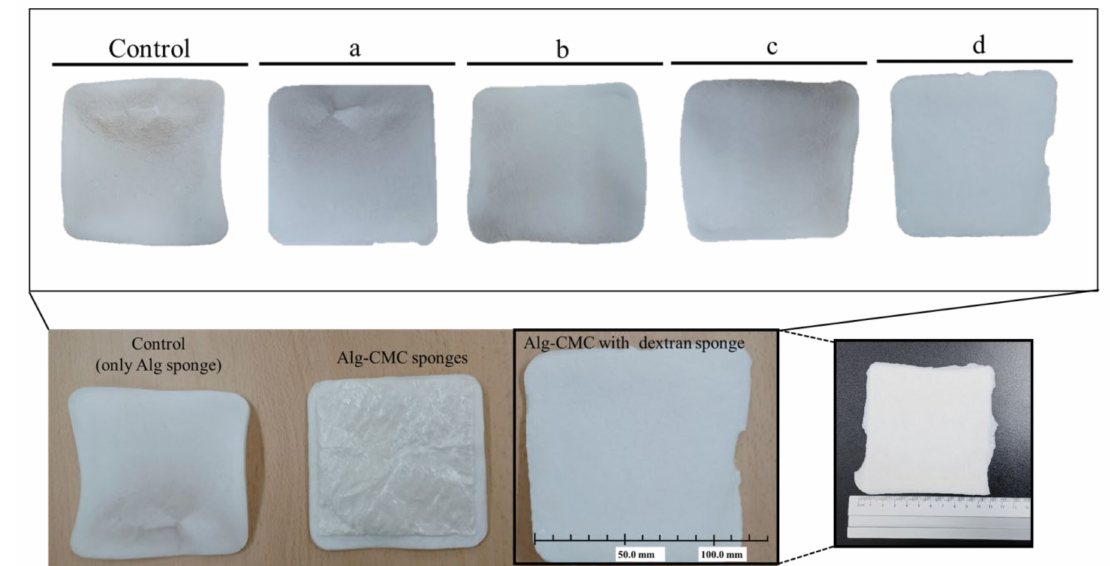
Figure 3. Image of a control sponge; ( a ) Alg-CMC ratio (5:5); ( b ) Alg-CMC ratio (5:5) with dextran; ( c ) Alg-CMC ratio (7:3); ( d ) Alg-CMC ratio (7:3) with dextran (taken by Digital Camera